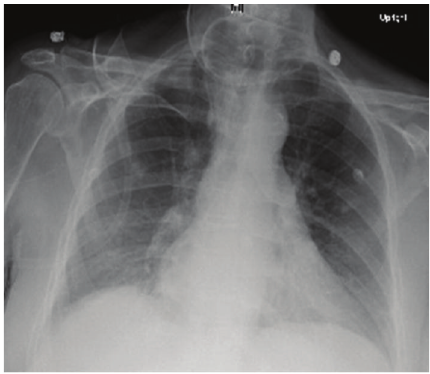
Figure 2: Bone marrow biopsy showing bone marrow necrosis which may be from tumor cells itself or the effect of tumor cells on marrow cells.